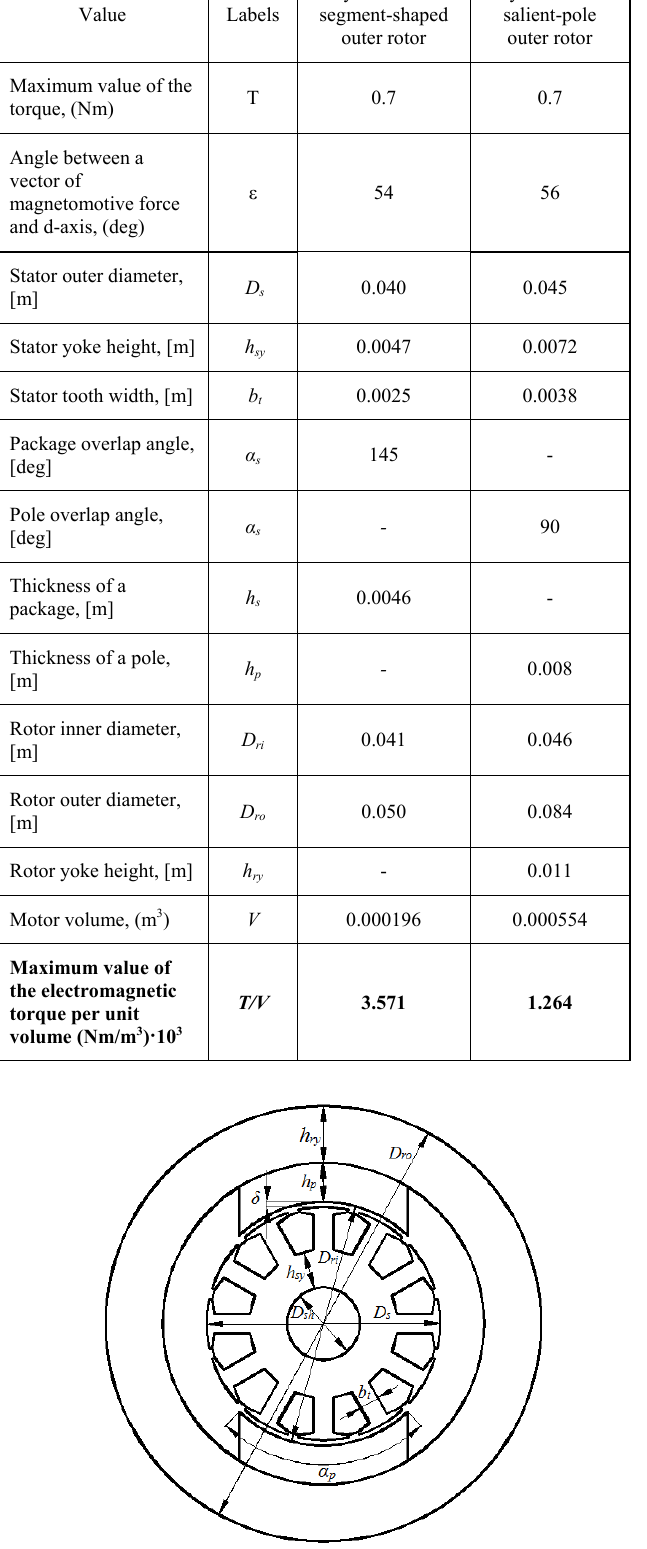
Fig. 11.Geometry of the salient pole SynRM with outer